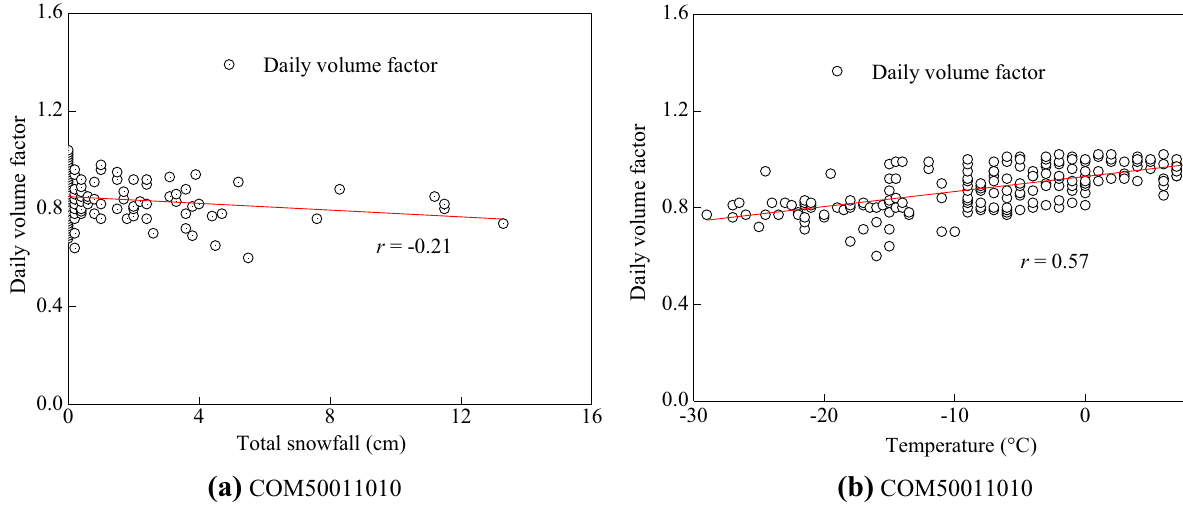
Fig. 5 Effects of snowfall and temperature on winter month 24-h traffic